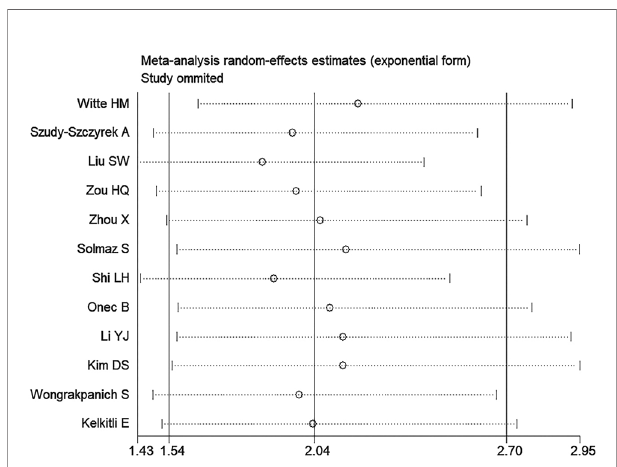
FIGURE 5 | Sensitivity analysis of the association between neutrophil- lymphocyte ratio (NLR) and overall survival of multiple myeloma (MM).